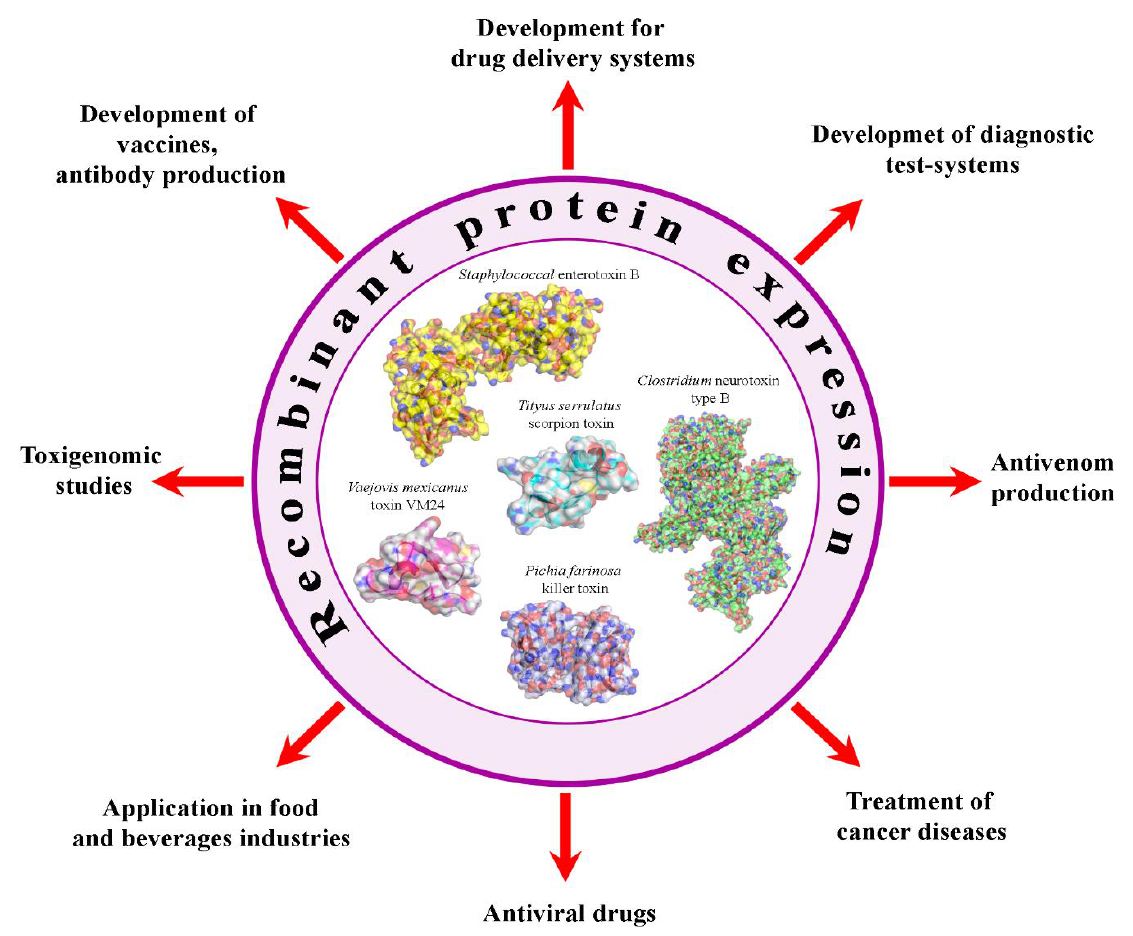
Figure 1 . Various applications of recombinant